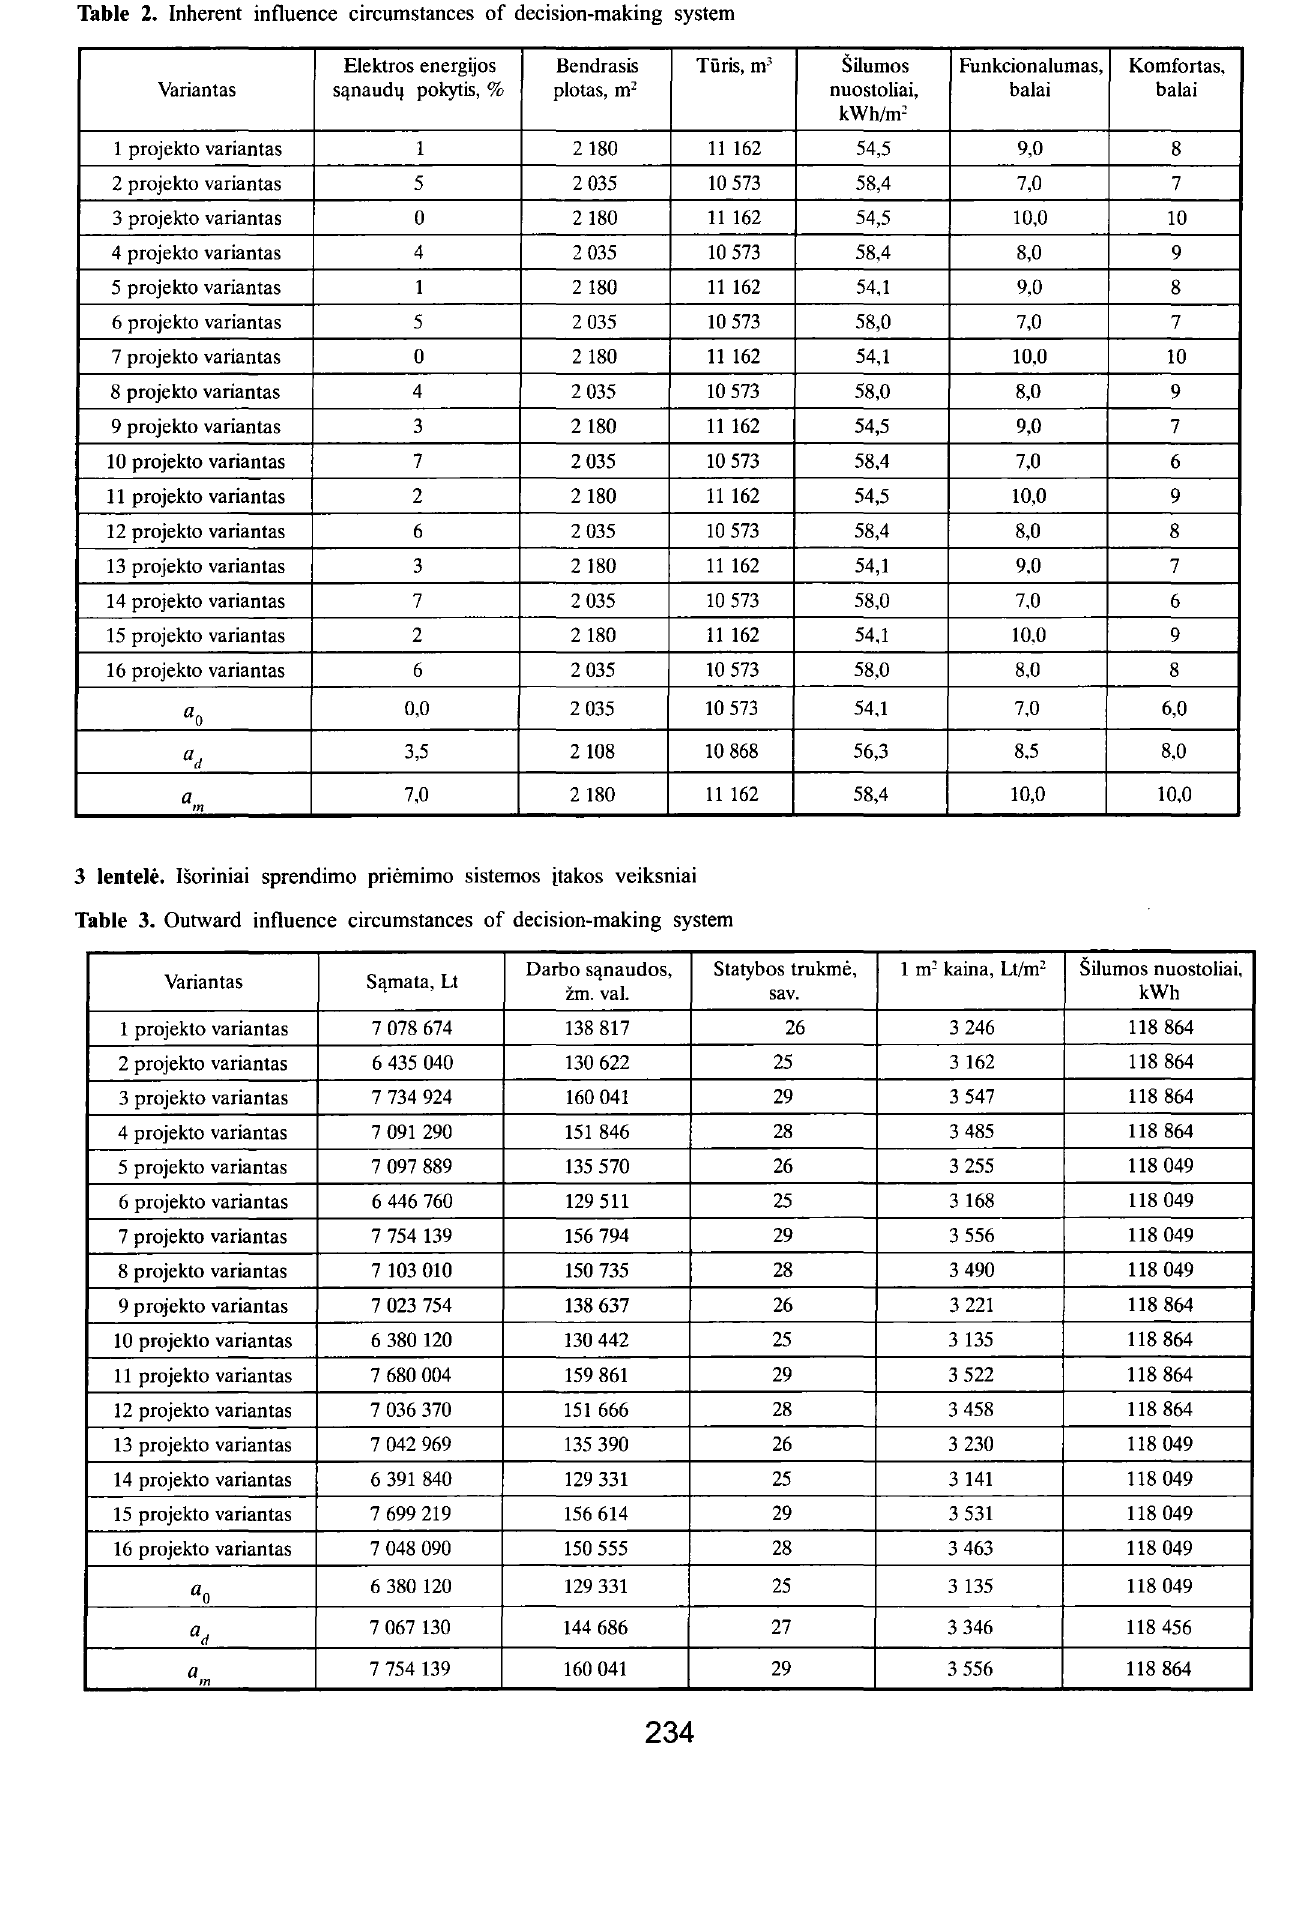
Table 2. Inherent influence circumstances of decision-making system Elektros energijos Bendrasis Tiiris, m 3 Silumos Funkcionalumas, Komfortas. Variantas S<jnaudl.) pokytis, % plotas, m' nuostoliai,